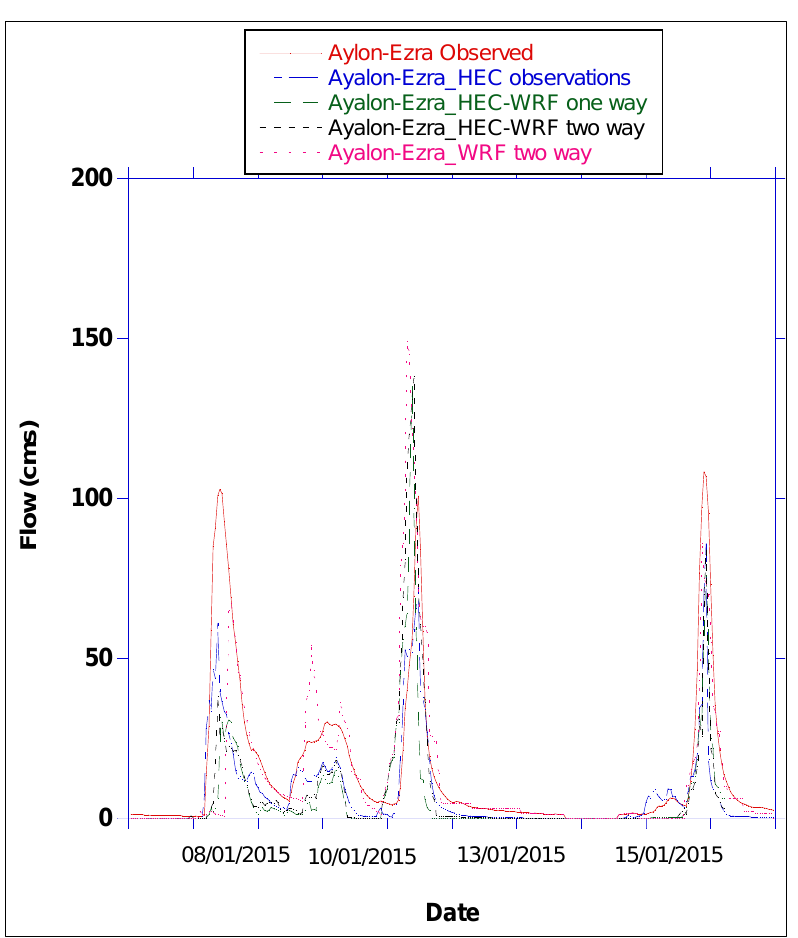
Figure 10. Observed hydrograph for Ayalon–Ezra hydrometric station ( red ) vs. simulate HEC-HMS hydrograph using observed precipitation as an input ( blue ), HEC-HMS hydrograph using WRF-Hydro one ( green ) and two way ( black ) simulated precipitation as an input and WRF-Hydro two way hydrograph ( pink ) for the period 6 January 2015 to 17 January 2015. Table 3. Results for the Nash–Sutcliffe test and correlation for observed hydrograph for Ayalon–Ezra hydrometric station vs. simulate HEC-HMS hydrograph using observed precipitation as an input, HEC-HMS hydrograph using WRF-Hydro one and two way simulated precipitation as an input and WRF-Hydro two way hydrograph for the period 6 January 2015 to 17 January 2015.